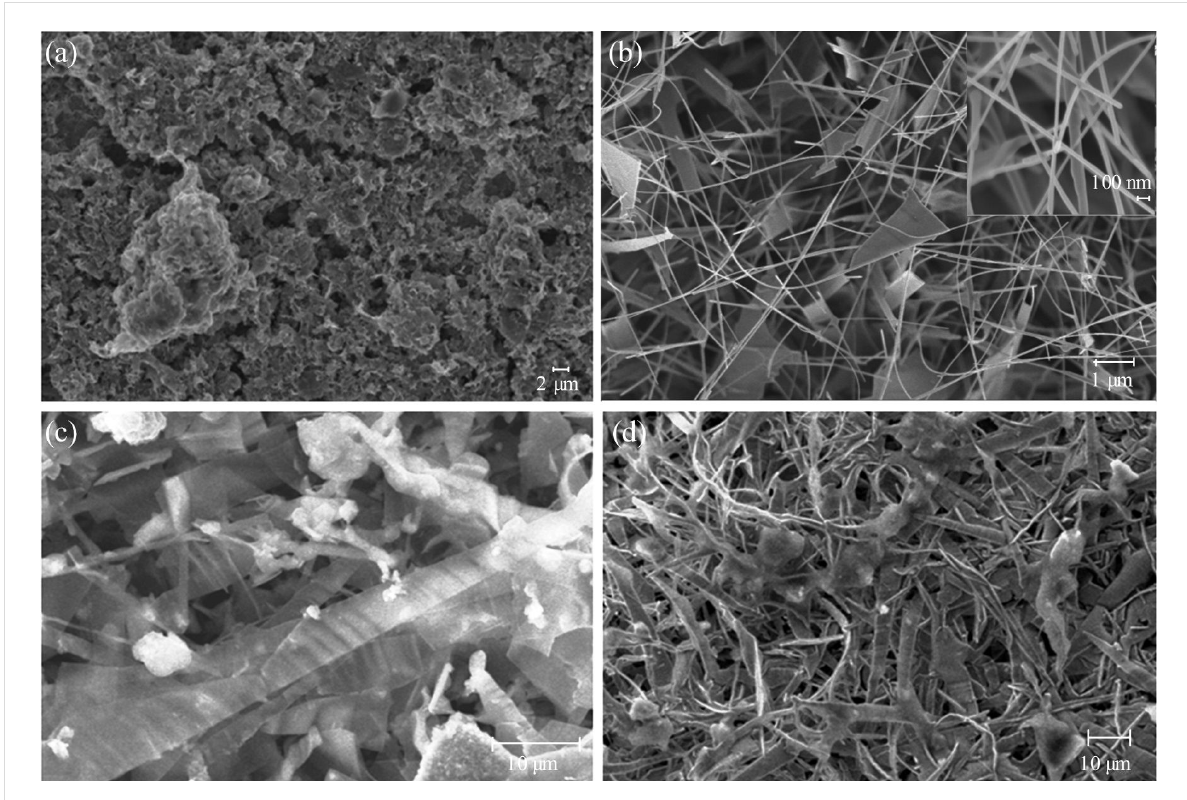
Figure 1: Scanning electron microscopy images of (a) the drop-cast ZnO nanoparticle sensor surface; (b) the pure ZnO nanowire sensor surface (inset: higher magnification FESEM image of ZnO NWs); (c) DT-ZnO NP + ZnO nanowire sensor surface; and (d) THMA-ZnO NP + ZnO nanowire sensor surface (note the change in